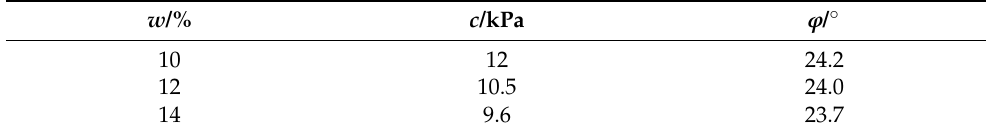
Table 1. Sand Table 1. Sand parameters.